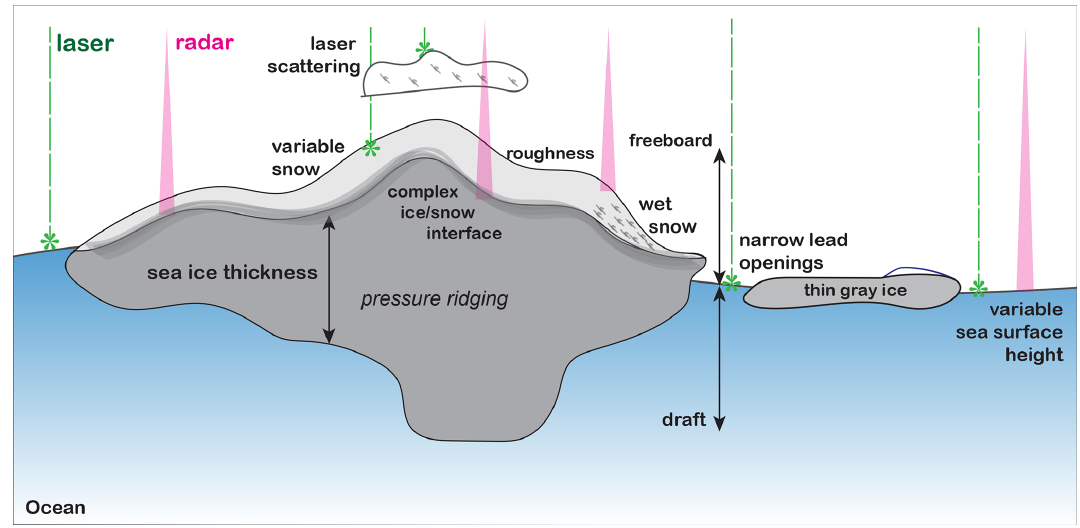
Figure 1. Schematic showing the typical approach and key challenges in active sea ice altimetry (laser, e.g. ICESat-2; radar, e.g. CryoSat-2) over winter sea ice. Not to